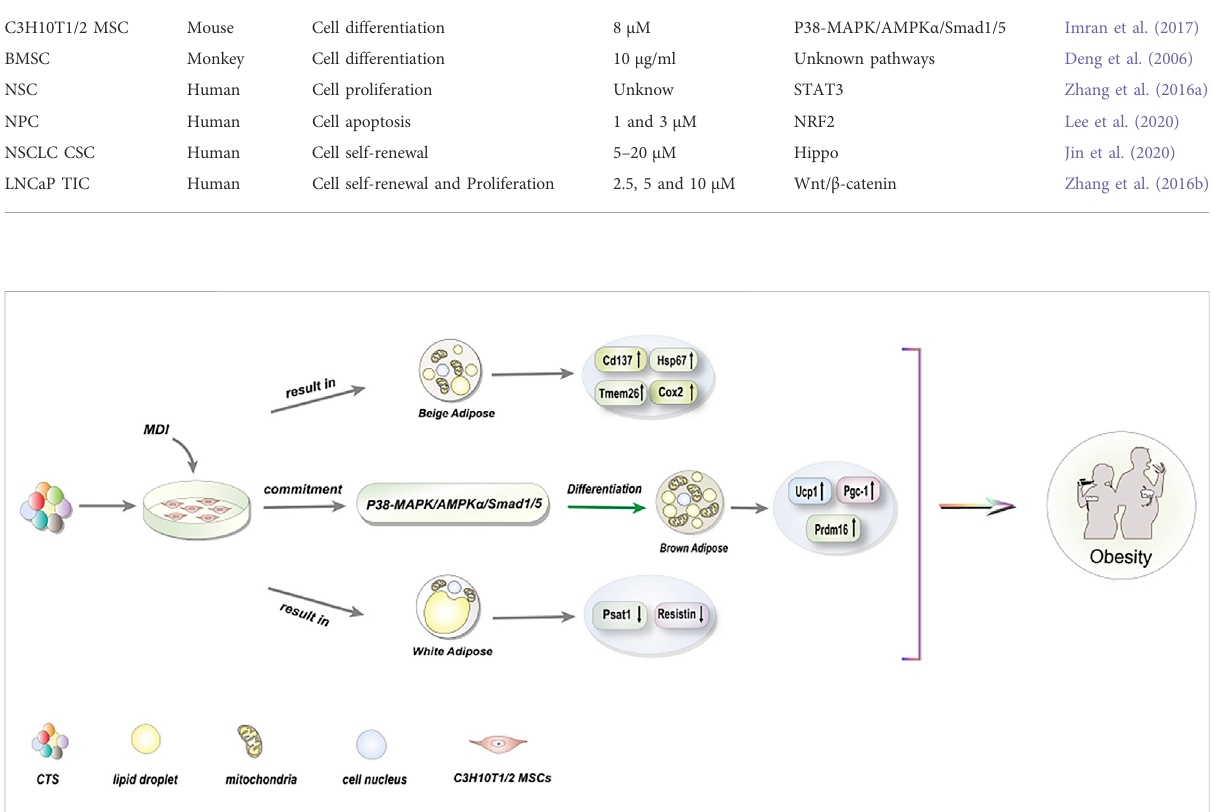
(Table 2), and discusses the mechanism by which CTS promotes cell proliferation/self-renewal and differentiation. This review demonstrates the potential for CTS to improve the application of stem cell therapies and stem cell transplantation and provide new therapeutic strategies for the high-incidence diseases.